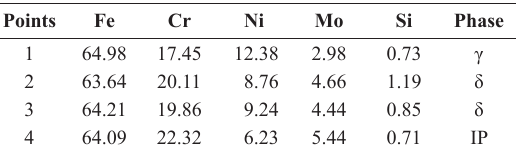
Table 4. Chemical composition of the points identified by EDS in Figure 3a (wt%).